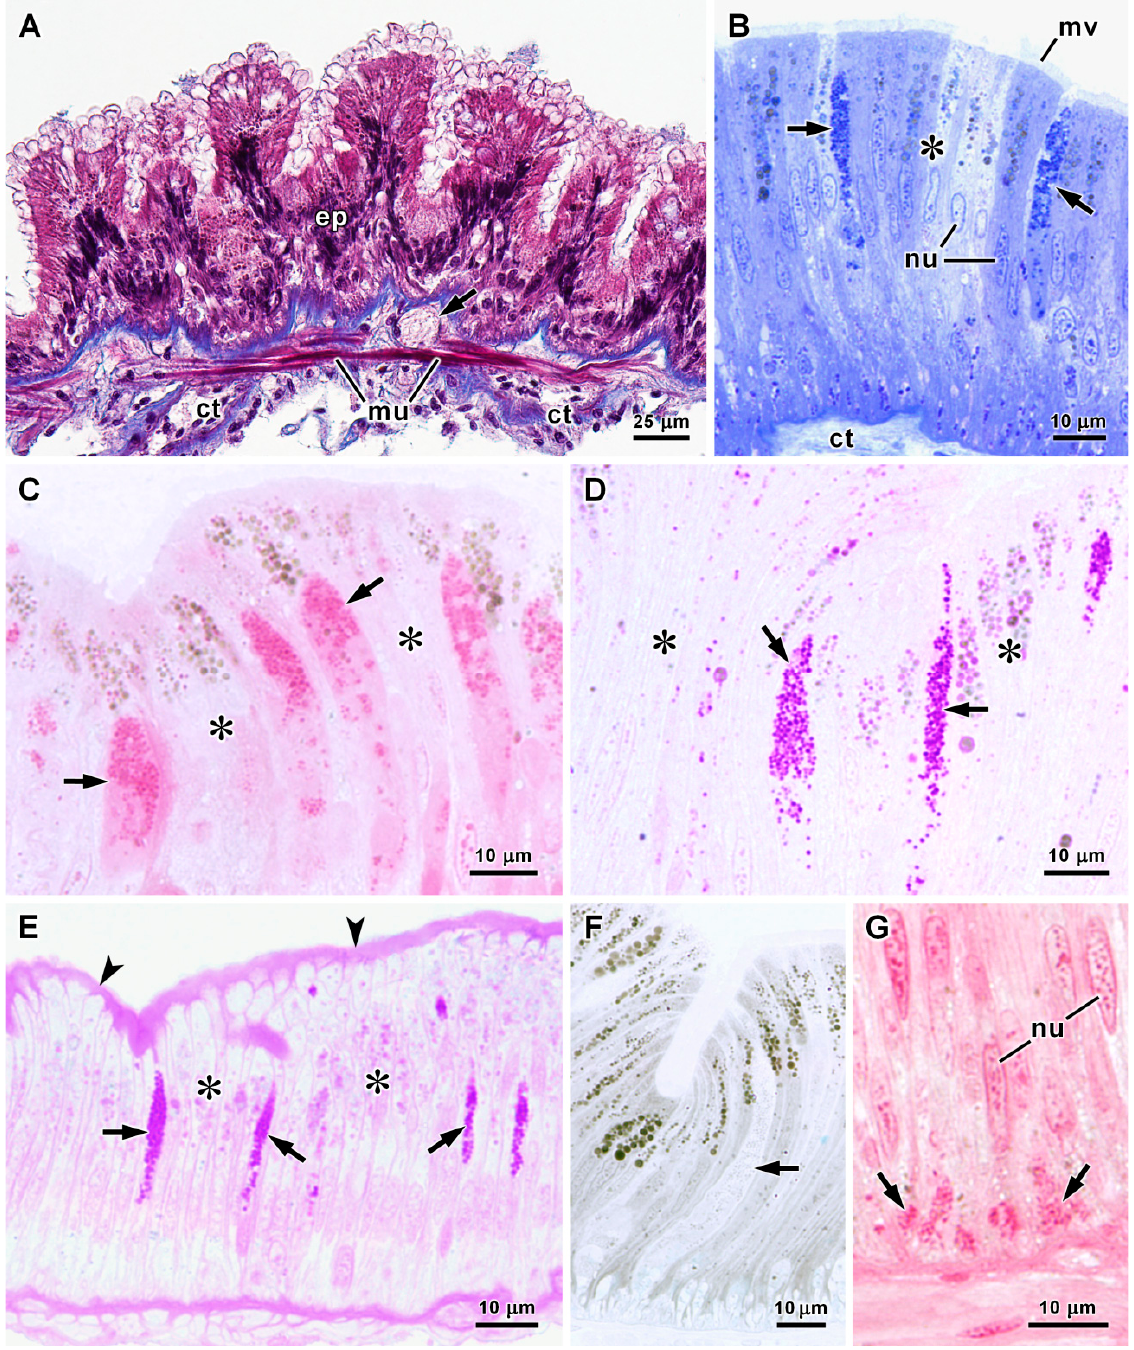
Figure 7. Stomach of C. angulata ( A – D , F , G ) and A. fascicularis ( E ) in histological ( A ) and semithin ( B – G ) sections. ( A ) Stomach wall stained by Masson’s trichrome. A transverse section of a nerve (arrow) is visible below the epithelium (ep). ( B – D ) Absorptive cells (asterisks) and basophilic secretory cells (arrows) in the stomach of C. angulata stained by meth- ylene blue and azure II ( B ), tetrazonium coupling reaction ( C ) and PAS reaction ( D ). ( E ) Secretory cells stained by PAS reaction (arrows) and absorptive cells (asterisks) in the stomach of A. fascicularis . The microvillous border is also stained (arrowheads). ( F ) Secretory cell (arrow) unstained by Alcian blue. ( G ) Basal cells (arrows) with vesicles stained by the tetrazonium coupling reaction. ct—connective tissue, mv—microvilli, mu—muscle fibres, nu—nuclei.